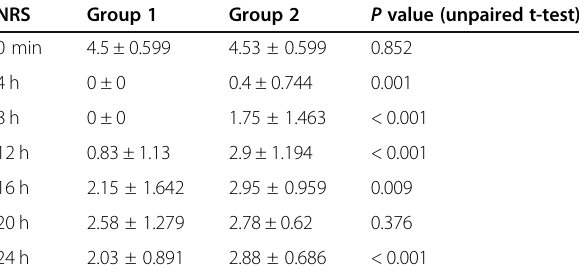
Table 3 Comparison of NRS scores in both groups NRS